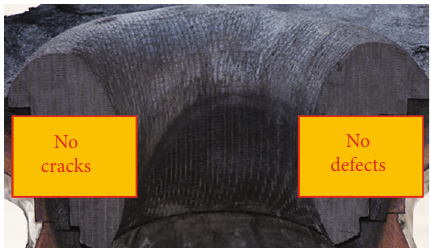
Figure 16: Throat insert cross-section after the SRM ground fi ring